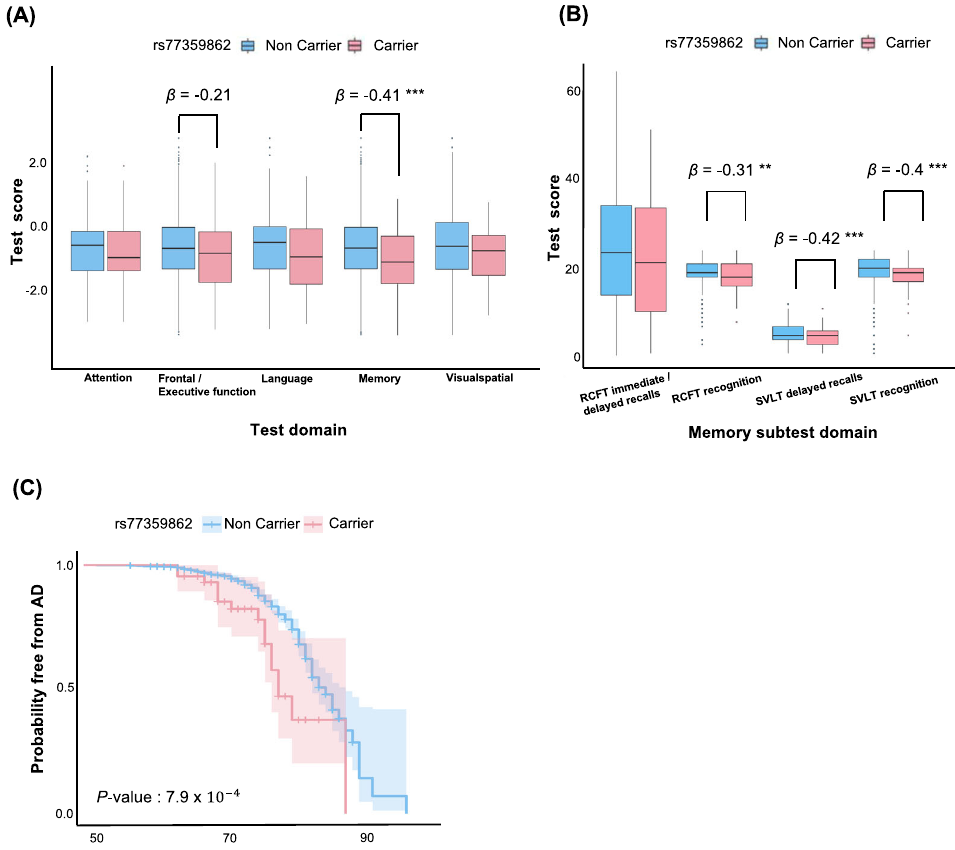
Fig. 2 Association of rs77359862 with brain imaging, cognitive test measures and AD onset. A Boxplots of Neuropsychological test (Seoul Neuropsychological Screening Battery (SNSB)) scores for attention, executive function, language, memory and visuospatial ability among rs77359862 carriers and non-carriers. Rs77359862 carriers had signi fi cantly lower scores for executive function and memory. ** p -value < 0.01, *** p -value < 0.001. B Boxplots of subtests of memory domain in SNSB. Four subtests of memory function were assessed including visual memory (Rey-Complex Figure Test (RCFT) immediate/delayed recalls and recognition) and verbal memory (Seoul Verbal Learning Test (SVLT) delayed recalls and recognition). Rs77359862 carriers had signi fi cantly lower scores for all subtests, except RCFT immediate/delayed recalls. ** p -value < 0.01, *** p -value < 0.001. C The rs77359862 missense variant signi fi cantly lowers age of AD onset. The effect of rs77359862 genotype on onset age was evaluated using Kaplan – Meier analysis and the survival curves for carriers and non-carriers of the missense variants were compared using the log-rank regions were highly variable compared to those in the other parts of the protein as deduced by the root mean square fl uctuation (RMSF) plot. Interaction on the interface between HOIP UBA WT and SHARPIN UBL WT is strengthened by residues that contribute to hydrogen bonds and salt bridges [40]. Upon 60 ns MD simulation, we compared structural changes by using the averaged atomic coordinates for the stabilized last 20 ns (Fig. 3E, F). The comparative analysis revealed that the WT complex interface was built with ten hydrogen bonds and seven salt bridges, while the number of hydrogen bonds and salt bridges in the mutant complex HOIP UBA -SHARPIN UBL (R274W) had decreased to 4 and 0, respectively (Supplemental Table S7), indicating that the mutant in SHARPIN induced a weaker interaction between the HOIP UBA and SHARPIN UBL (R274W) (Fig. 3F and supplemental Fig. S6) (detailed information is provided in supplementary Text 7 and supplemental Figs. S7 – 8).